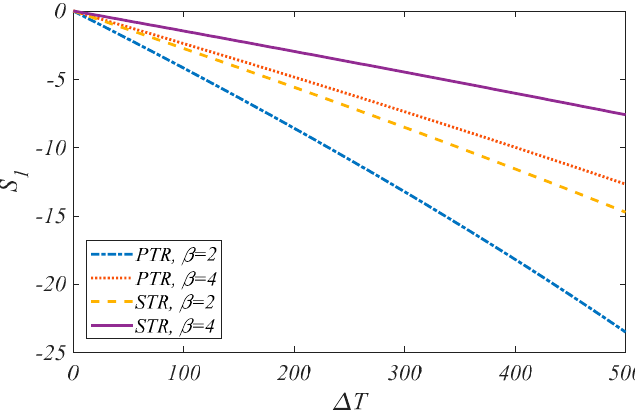
Figure 13. Sensitivity of the natural frequency of MHCAP with clamp-clamp boundary conditions to